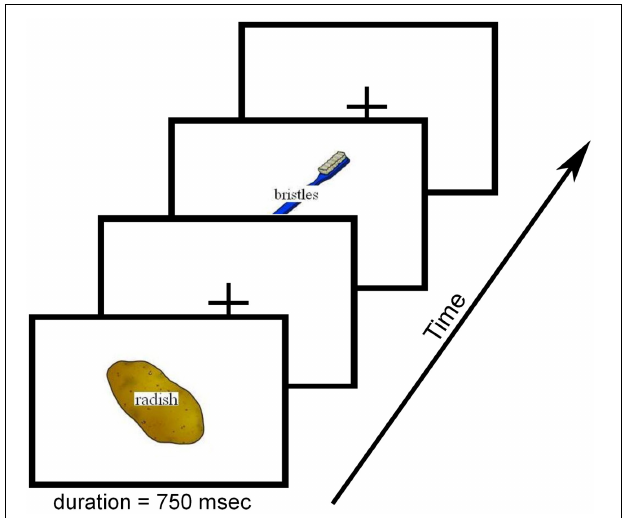
FIGURE 1 | Experimental Design. An overview of the task design is shown here. The figure depicts a typical sequence presenting two different trial types (categorically-related and part-whole). Pictures and words were presented simultaneously (duration = 750ms). Trial ordering was randomized across conditions and the inter-stimulus interval was jittered between 3 and 19s with a mean interval of 8s.